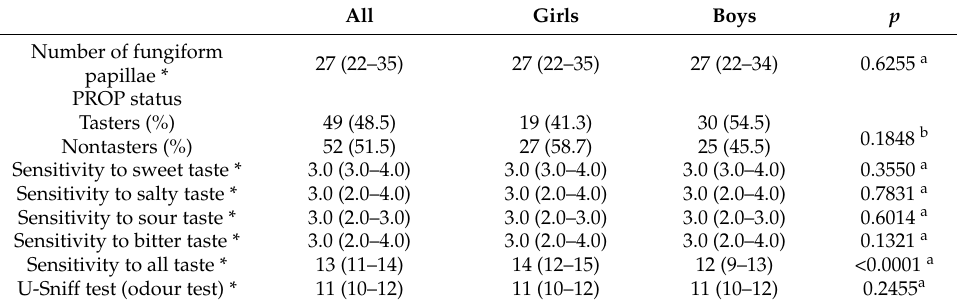
Table 2. Characteristics of the study sample (performed